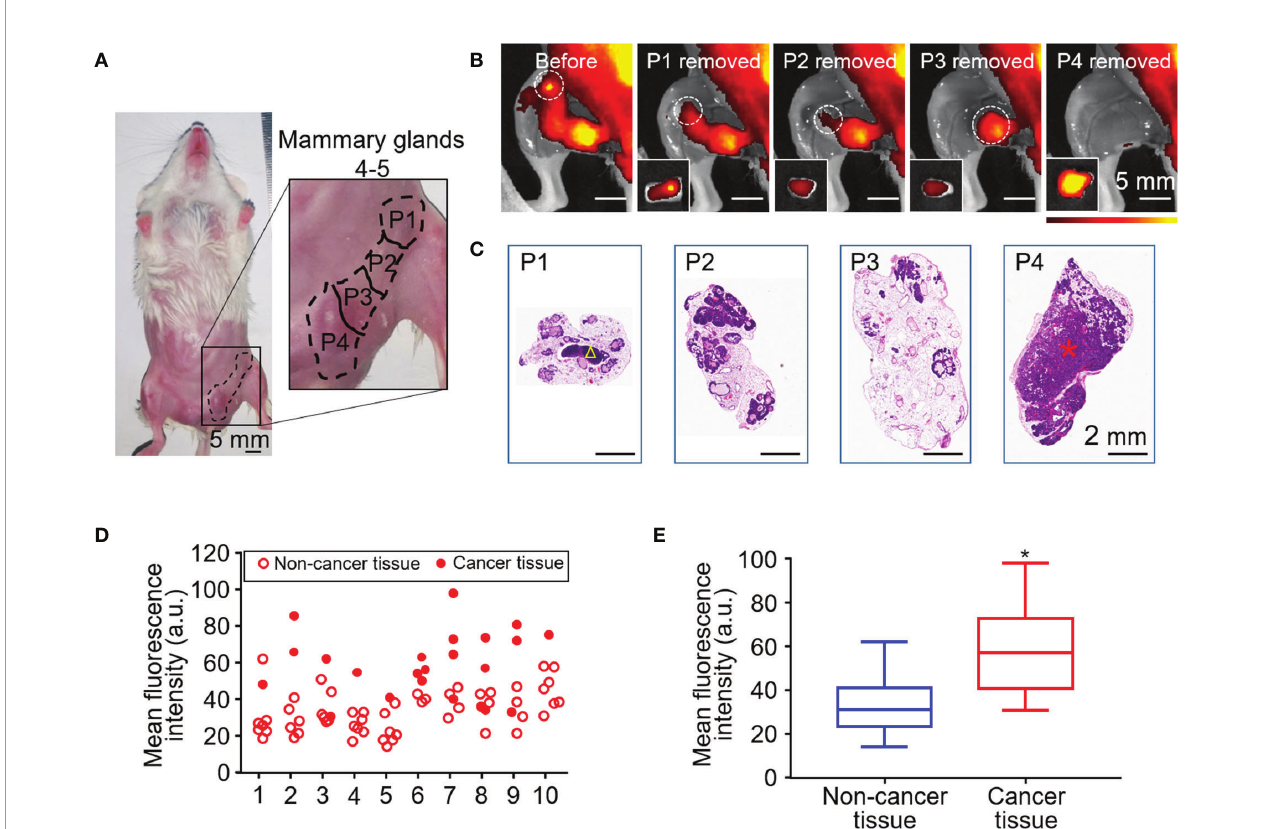
FIGURE 3 | HSA-ICG fl uorescence imaging in a mouse model of spontaneous breast cancer. (A) Picture of mammary glands 4 and 5 divided into four approximately equal quadrants (P1 – 4), which were resected sequentially 24 h after the injection of HSA-ICG (1 mg/ml). (B) Representative fl uorescence images before resection (leftmost) and after each sequential resection. Tissues resected (P1 – 4) are marked in white circles, and the corresponding ex vivo fl uorescence images of excised tissues are shown as insets on the lower left. (C) Histological examination of resected pieces (P1 – 4), corresponding to the fl uorescence images in panel (B) A yellow triangle in P1 marks a lymph node; a red asterisk in P4, a cancer lesion. (D) The fl uorescence intensity distribution of the resected mammary gland tissues (P1 – P4) in every case (n = 10). (E) Mean fl uorescence intensity of 23 resected cancer tissues and 57 non-cancer tissues pooled from the 10 mice in panel (D) (unpaired Student ’ s t test, * P <